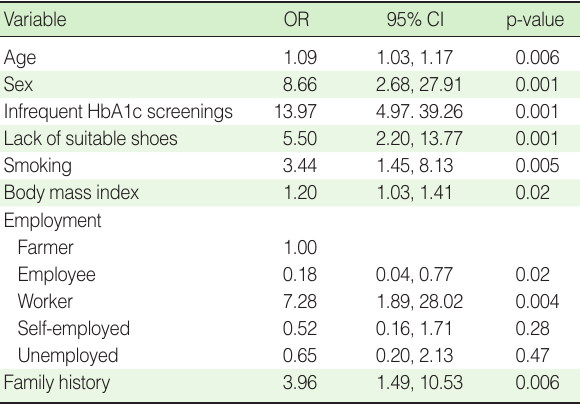
Table 2. The final model of the adjusted ORs of risk factors for am- putation in diabetic patients, calculated using conditional logistic